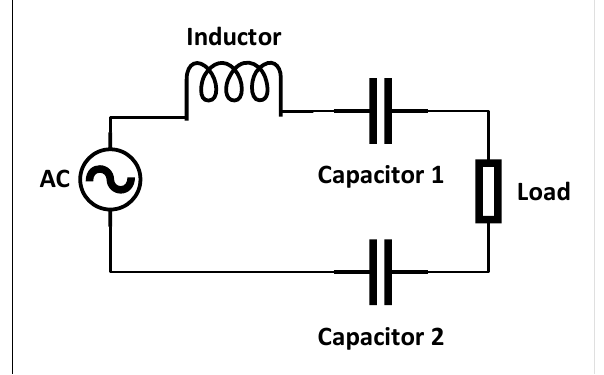
Figure 4. The simplified CCWPT